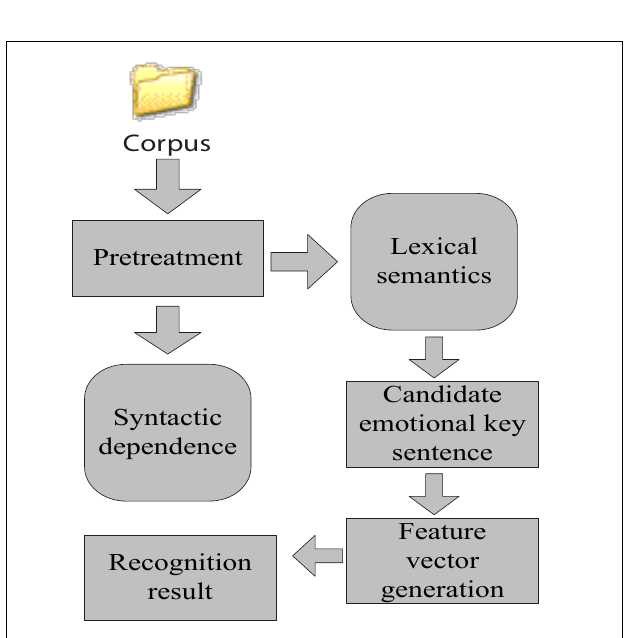
FIGURE 5 | The overall structure of the long and short-term memory network.